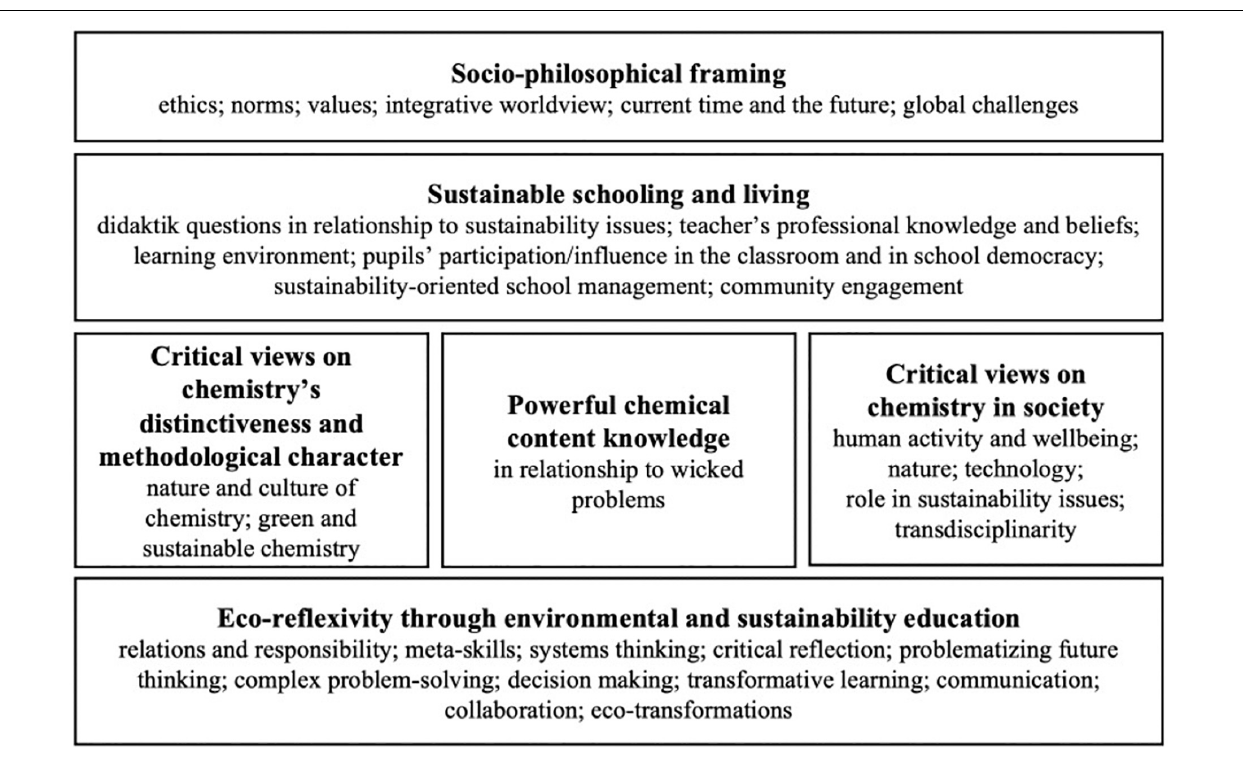
FIGURE 2 | Didaktik model for eco-reflexive chemistry education (Herranen et al., 2021, p.